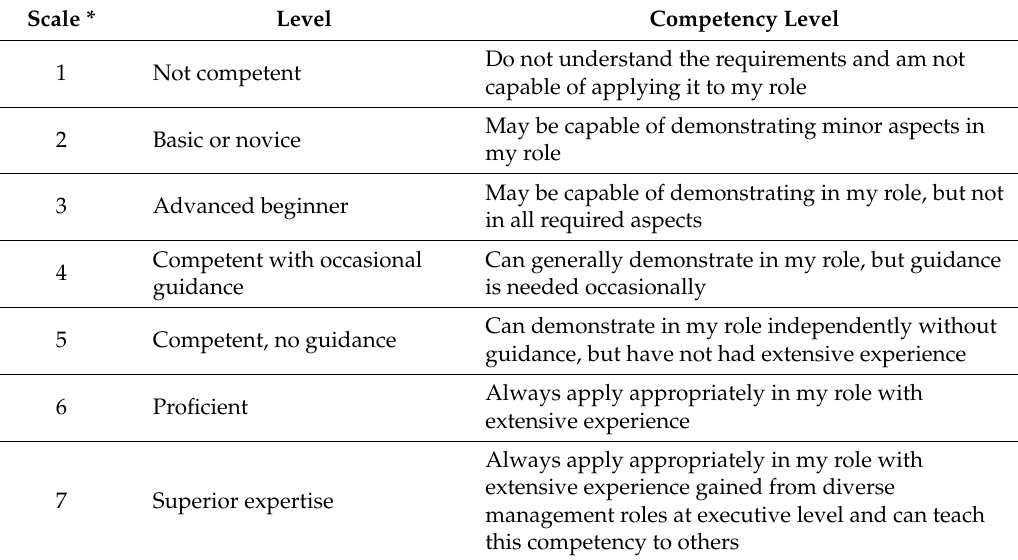
Table A1. MCAP Competency Likert Scale for